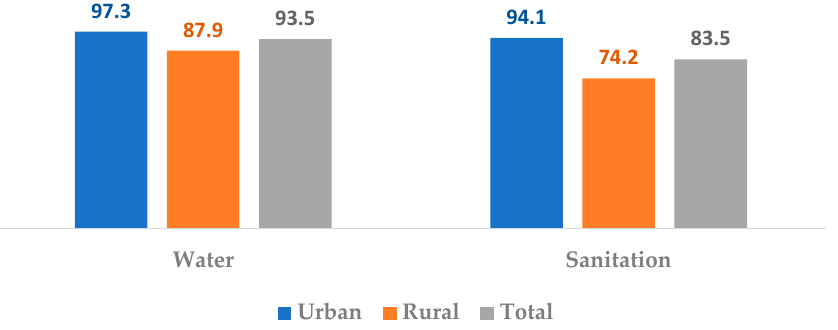
Figure 6. HOI for housing condition sector among youth 18–29 years by Residence. Note: Authors, data from HCP open data (www.hcp.ma) (accessed on 1 April 2022).